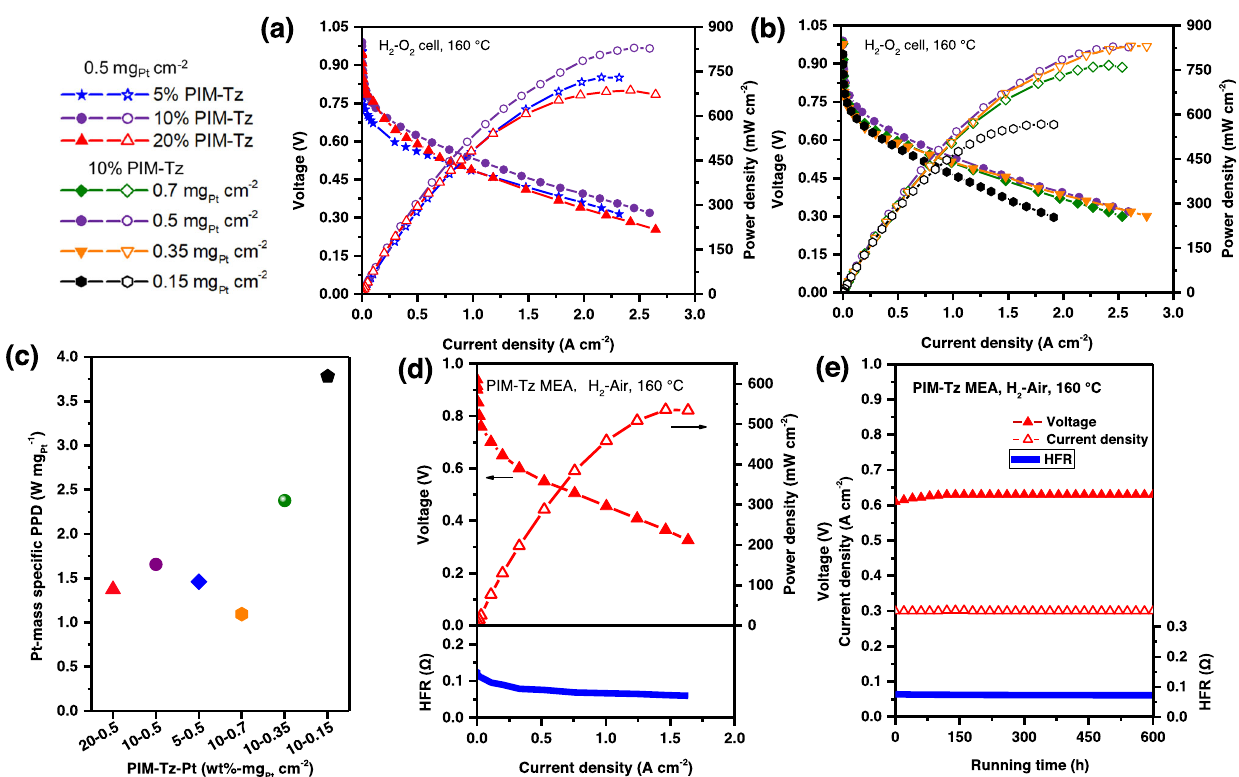
Fig. 6 | HT-PEMFC performance of the MEAs using PIM-Tz as binder in the catalyst layer. a Varied PIM-Tz contents in the catalyst layer with the same Pt catalyst loading 0.5mg Pt cm − 2 and ( b ) varied Pt loading with a constant (10wt%) PIM-Tz content. Solid symbols for the voltage and open symbols for the power